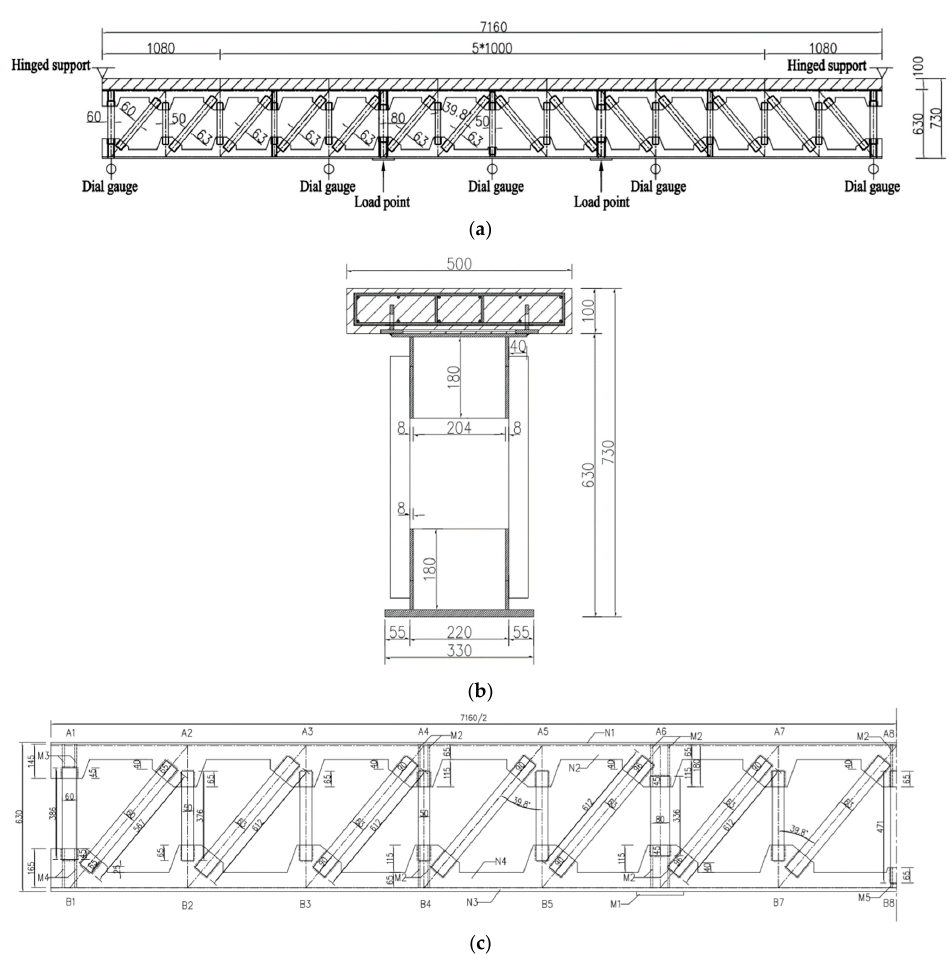
Figure 3. The tested steel–concrete composite beam (unit: mm); ( a ) elevational view; ( b ) sectional view; ( c ) detail size. Appl. Sci. 2019 , 9 , x FOR PEER REVIEW